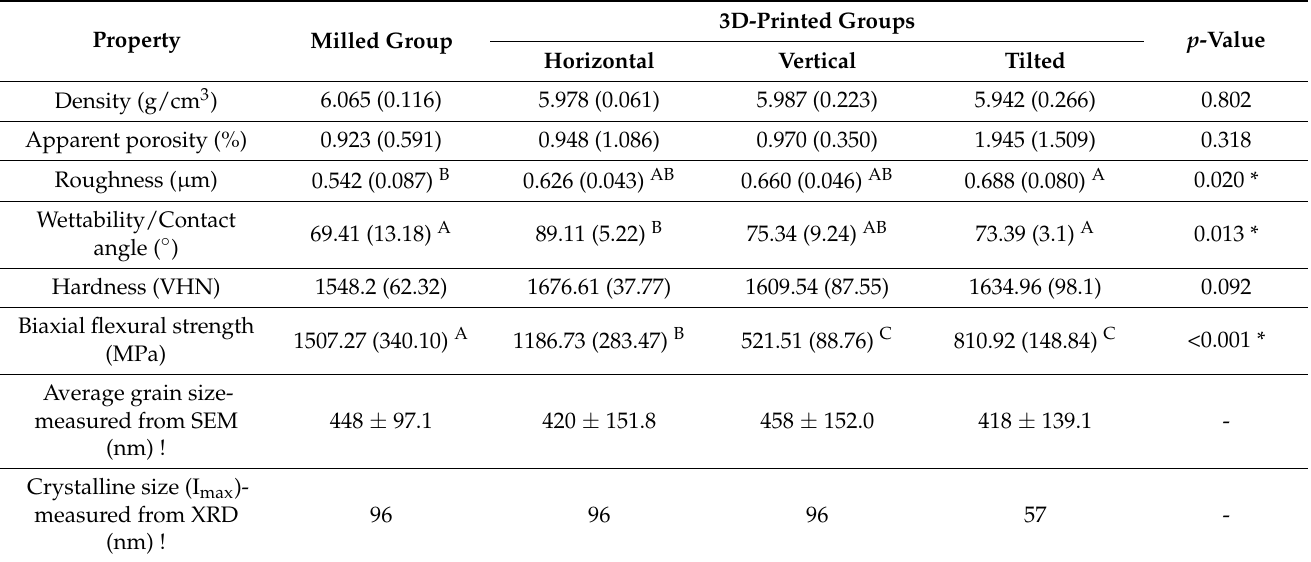
Table 2. Mean (SD) and significance between groups per tested